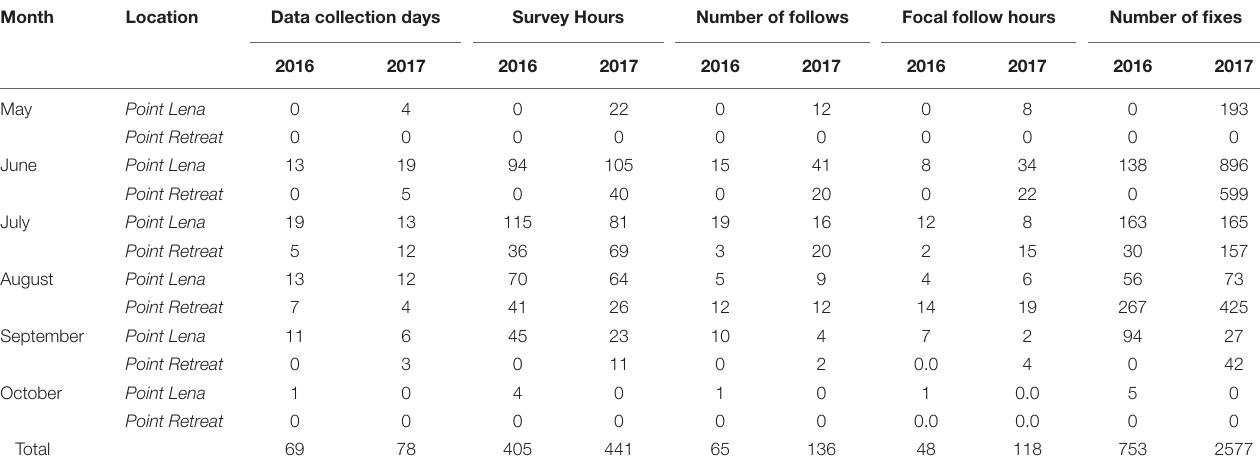
TABLE 3 | Summary of research effort for single adult whales at Point Lena and Point Retreat for 2016 and 2017 field seasons. Month Location Data collection days Survey Hours Number of follows Focal follow hours Number of fixes